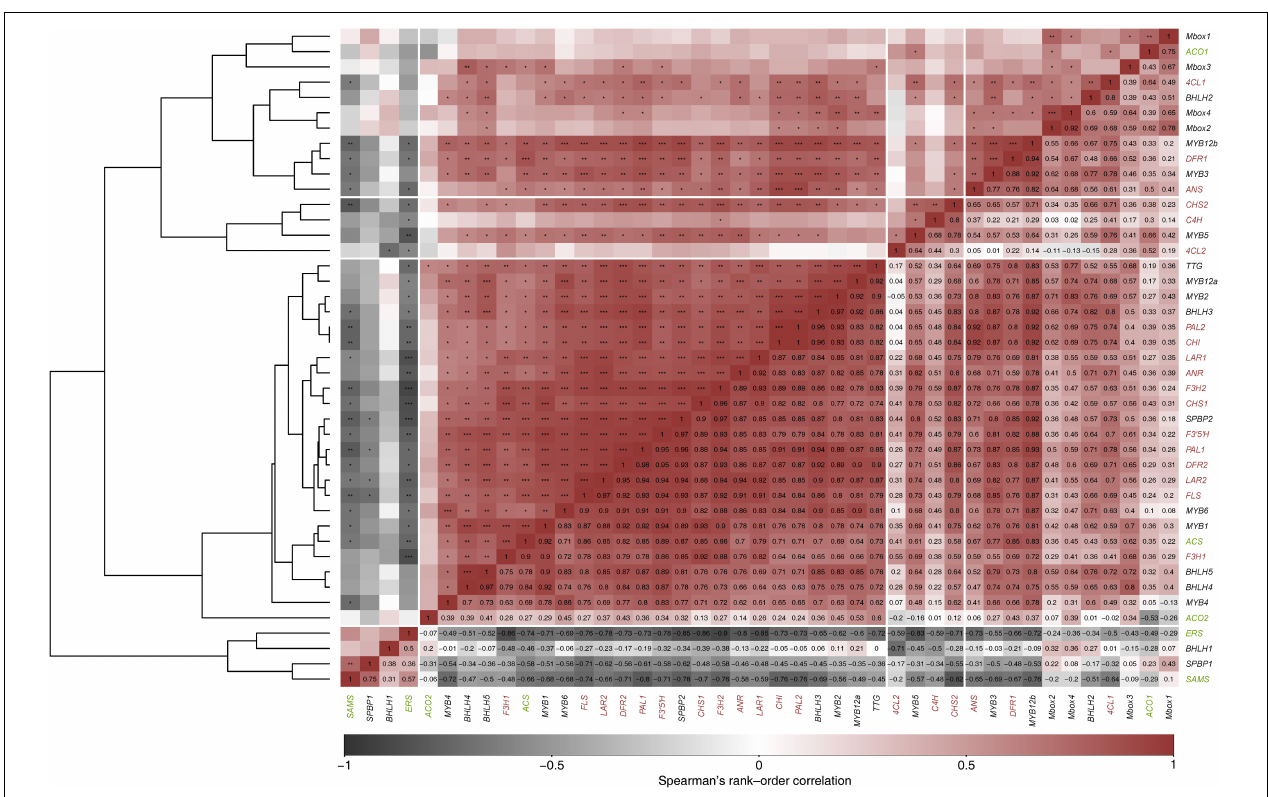
FIGURE 6 | Correlation analysis of gene expression data. The correlation matrix was constructed using Spearman’s rank-order correlation. Spearman’s correlation coefficients are shown in the lower triangle, while the significance of the association samples using a two-sided test ( p < 0.05) is denoted by asterisks in the upper triangle. The genes are ordered according to hierarchical cluster analysis (cluster agglomeration using complete linkage) constructed based on 1-corsp dissimilarity matrix (left